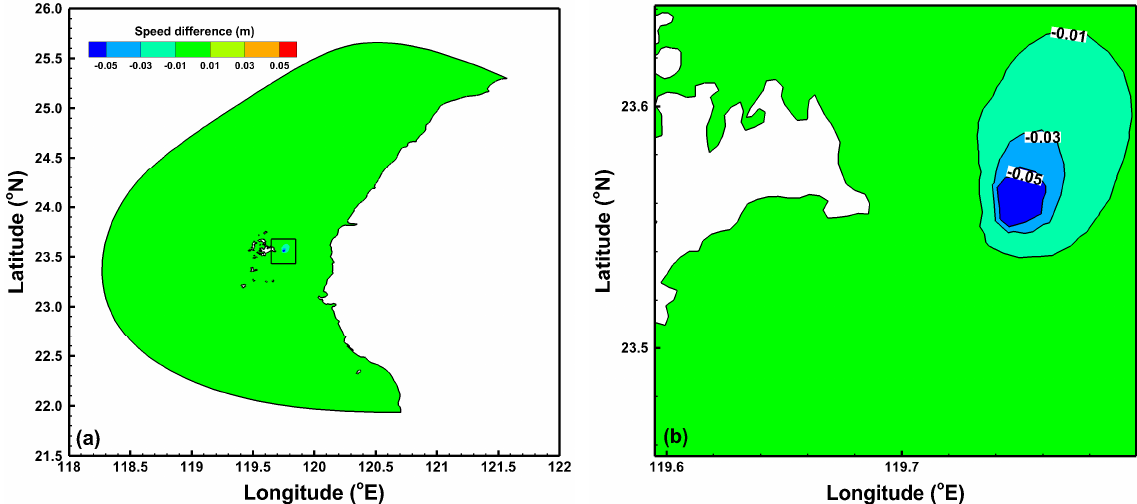
Figure 11. Difference in the mid-ebb tidal current for the ( a ) far-field and ( b ) near-field with and without a turbine array.